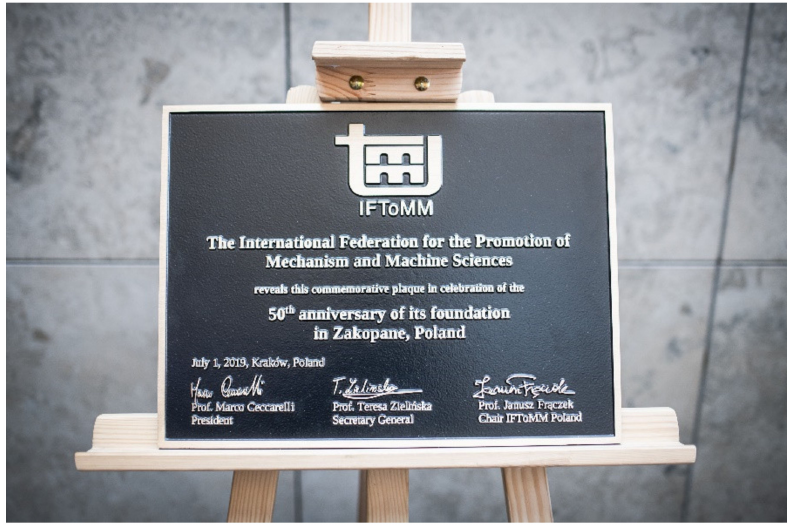
Figure 1. The bronze commemorative plaque for the 50-year anniversary of